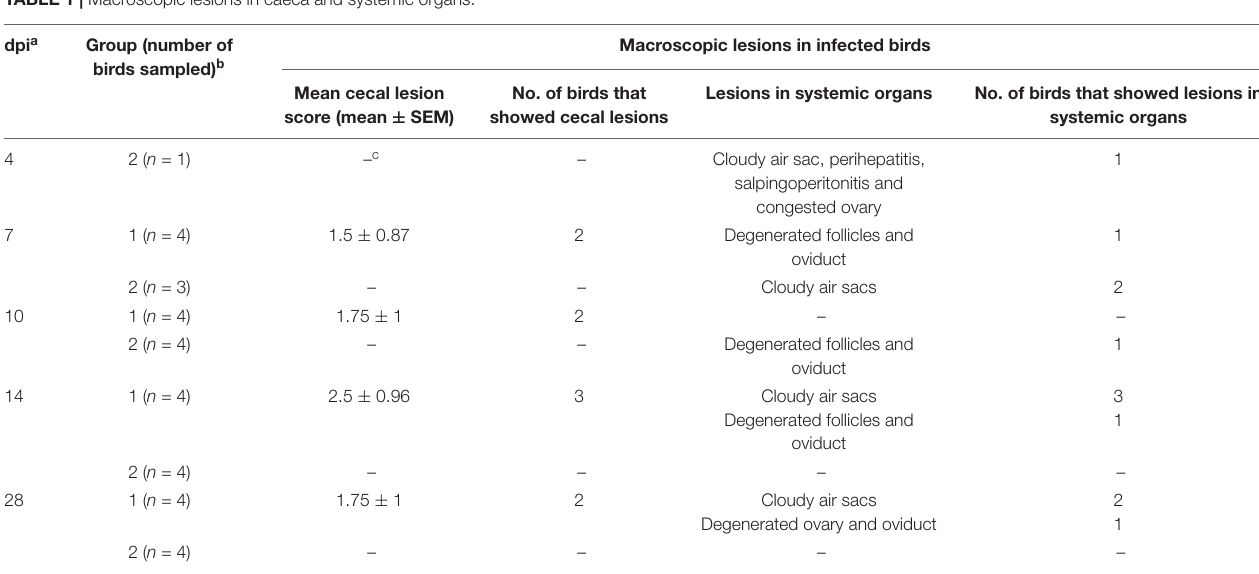
FIGURE 2 | Macroscopic lesions. Severe peritonitis in the dead bird due to infection with a lux -tagged avian pathogenic E. coli (A) ; thickening of the cecal wall with fibrinous mass in the lumen caused by H. meleagridis infection (LS4, group 1) (B) . TABLE 1 | Macroscopic lesions in caeca and systemic